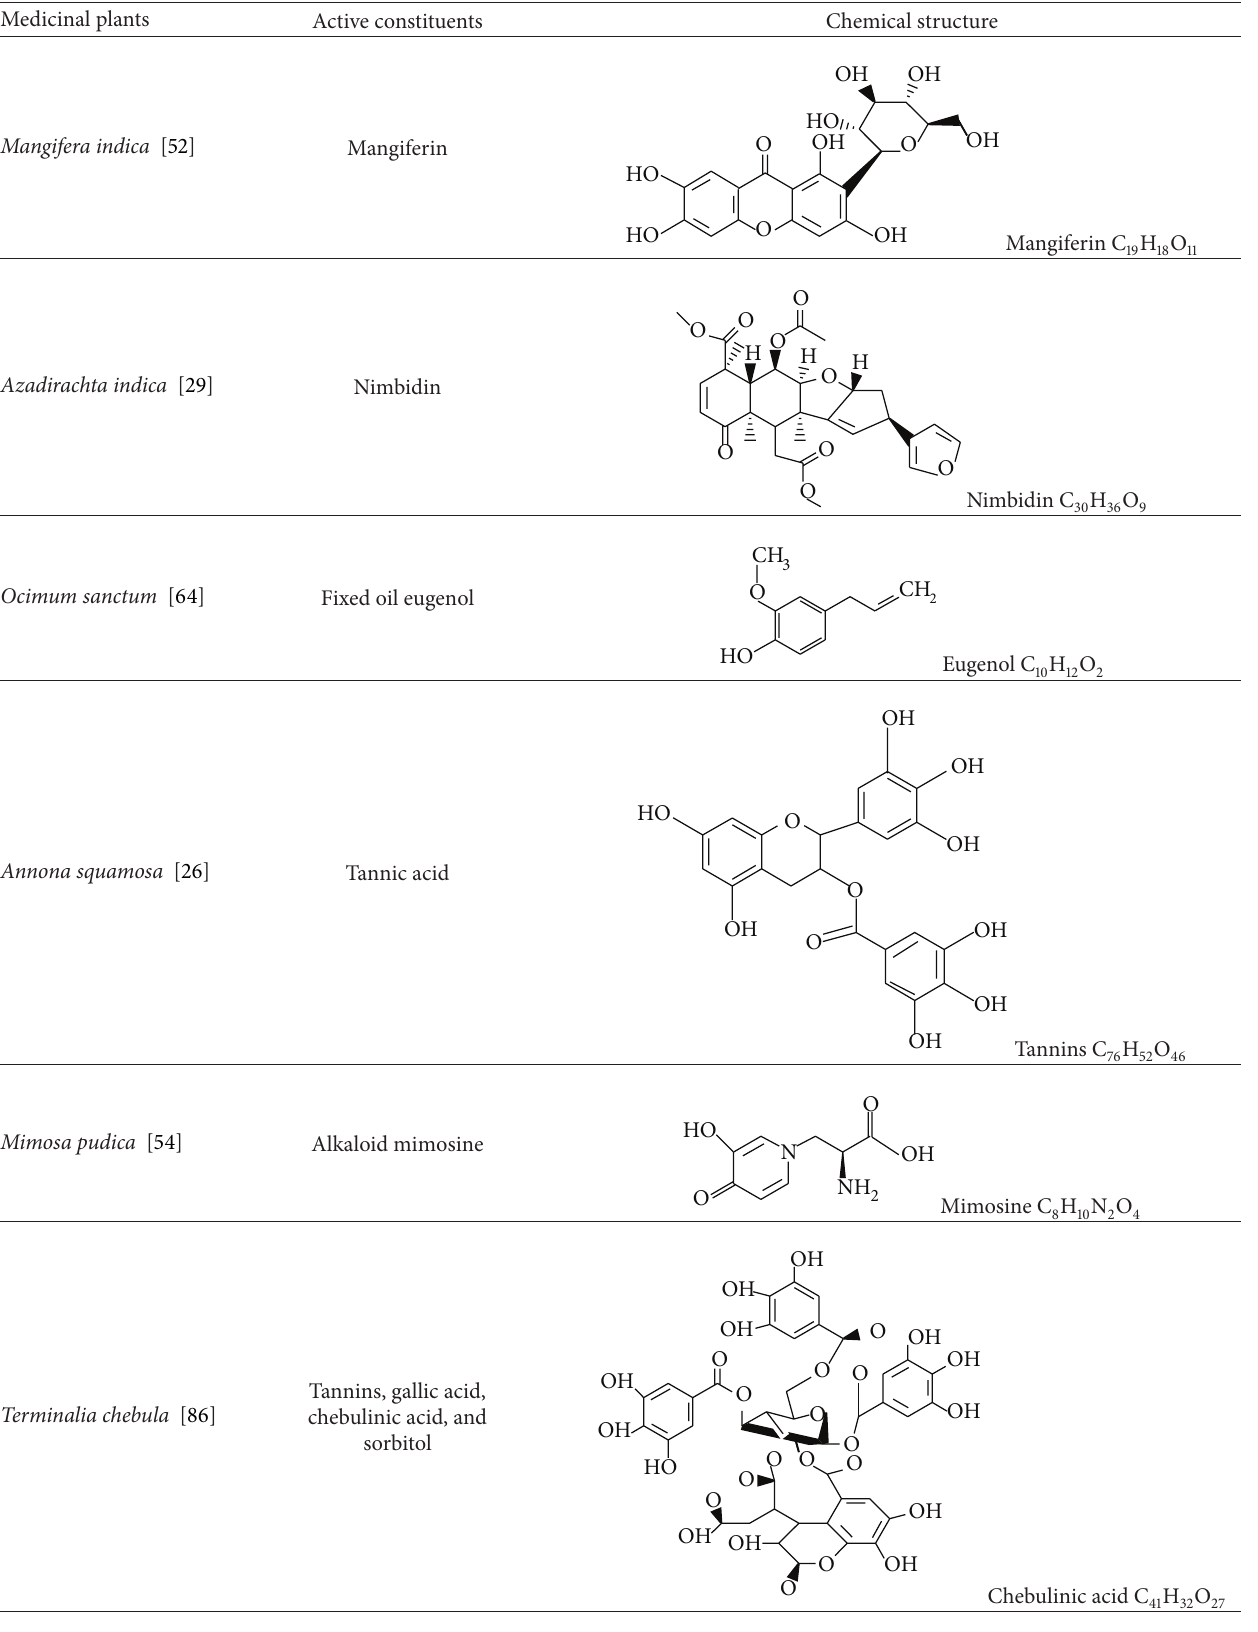
Table 1: Ulcer protective effect of some active constituents isolated from herbal drugs. Medicinal plants Active constituents Chemical